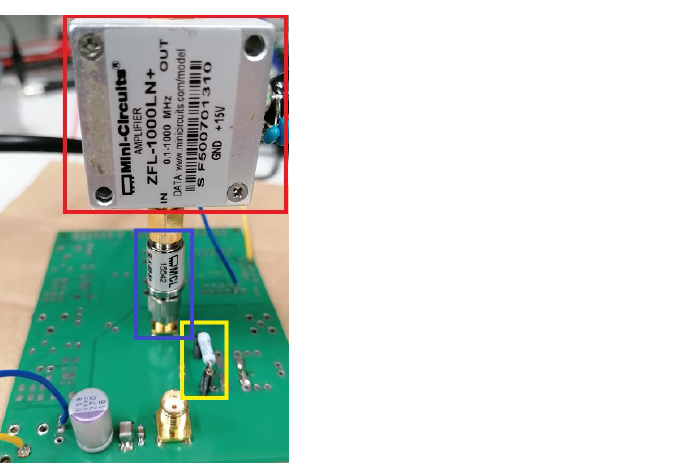
Figure 10: Auxiliary board with AC amplifier (red), DC blocker (blue) and 1Ω shunt resistor (yellow).